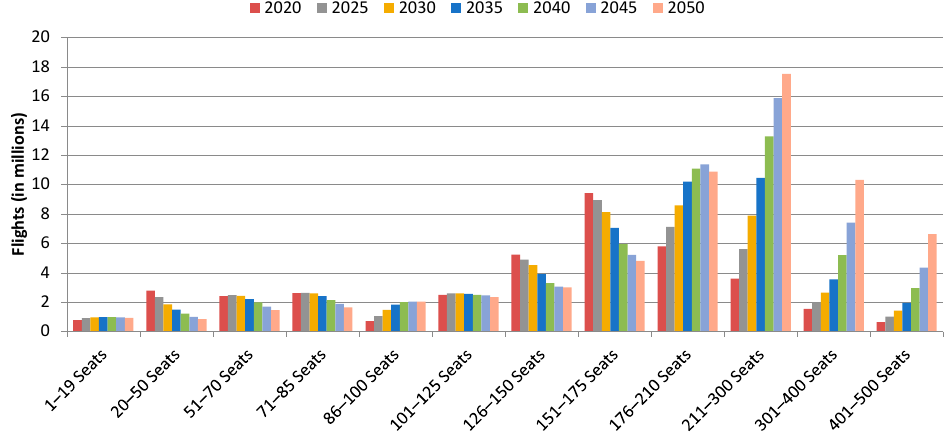
Figure 15. Fleet forecast results in the High Scenario.